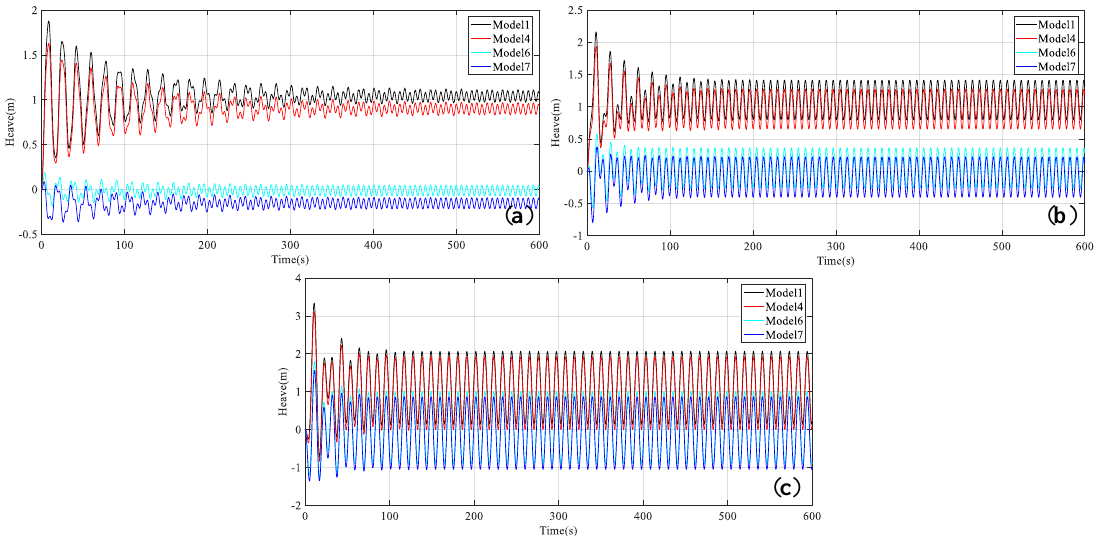
Figure 20. Comparison of the surge motion of Model 1, 4, 6, and 7 in the time domain: ( a ) LC1; ( b ) LC2; and ( c ) LC3.